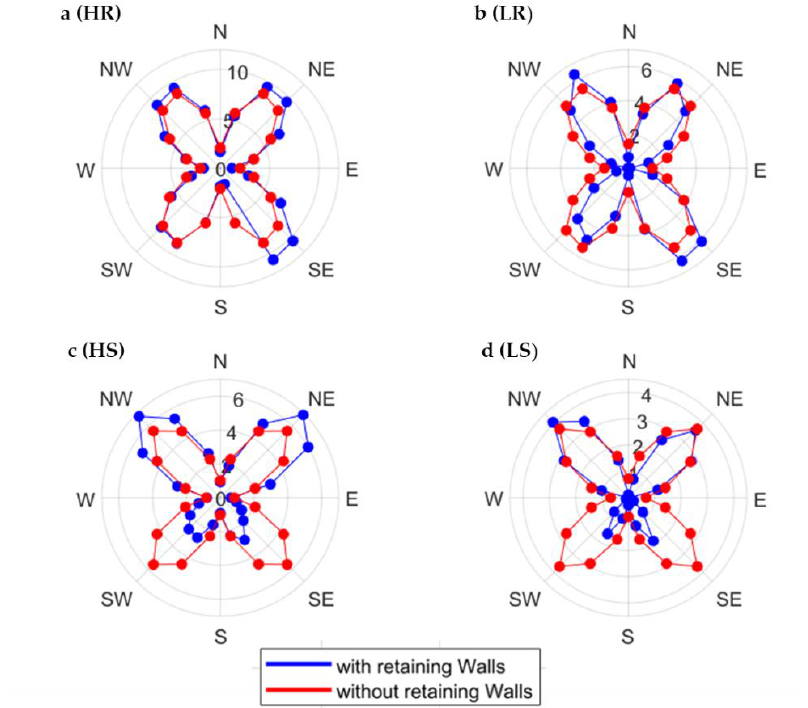
Figure 8. Polar diagram of PM emission potential (P) integrated over the surface of a Lead Glance stockpile for different geometrical configurations (( a )HR, ( b ) LR, ( c ) HS, and ( d ) LS). Blue and red lines refer to the configurations with and without enclosing walls.